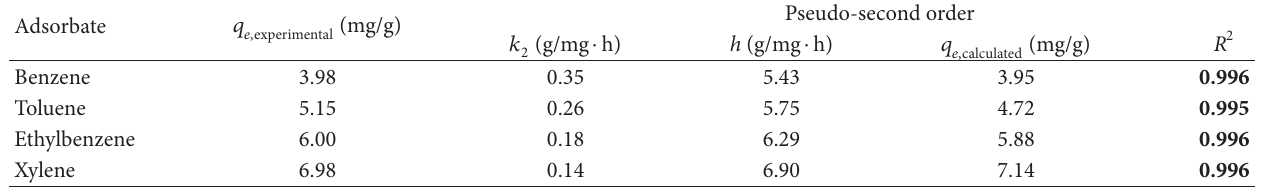
T 3: Parameters of pseudo-second order kinetic model obtained from the adsorption